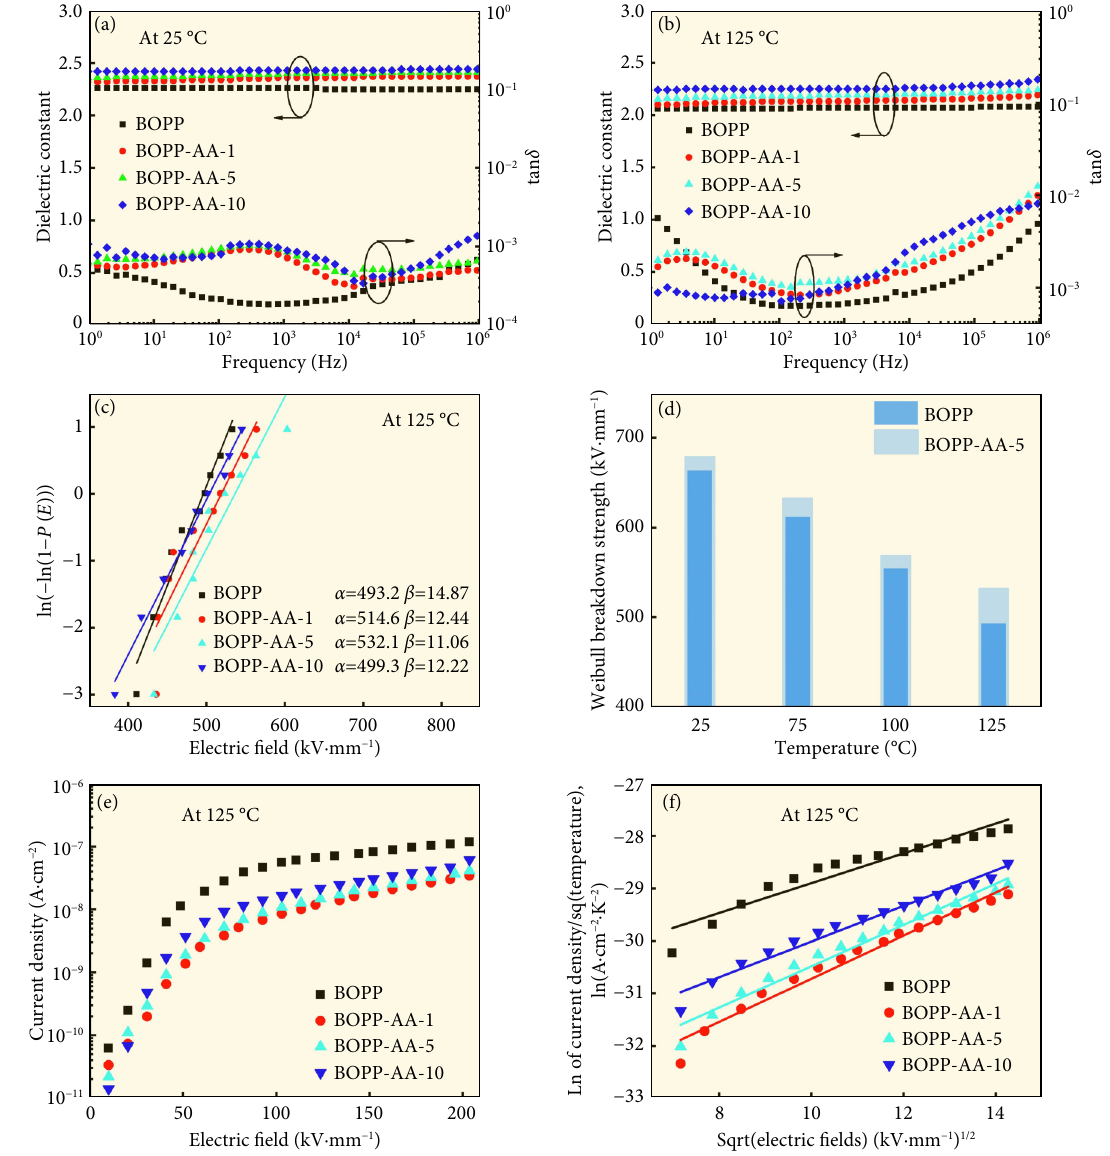
Fig. 4 Dielectric constant and dielectric loss of the BOPP–AA films at (a) 25 °C and (b) 125 °C. (c) Weibull distribution and (d) DC breakdown strength. (e) Leakage current density and (f) Schottky fitting